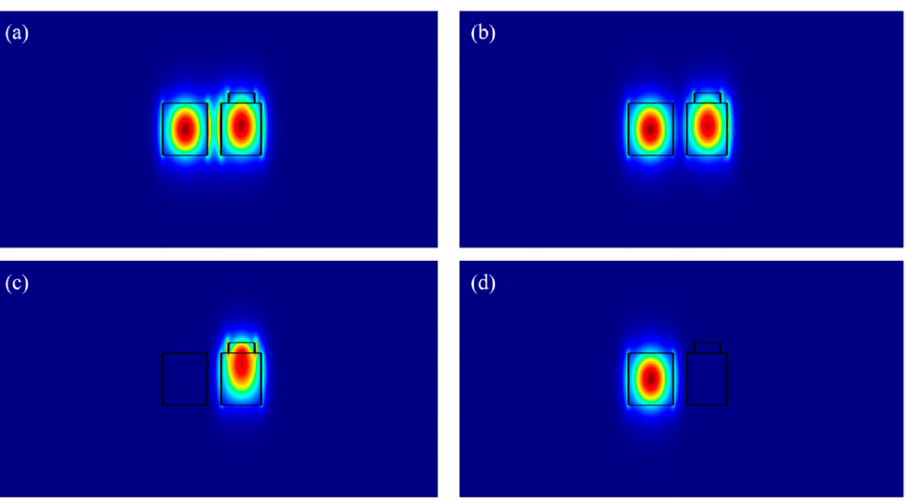
Figure 4. The modal intensity profiles of a silicon waveguide loaded with a GSST strip in the ( a ) amorphous and ( b ) crystalline states.